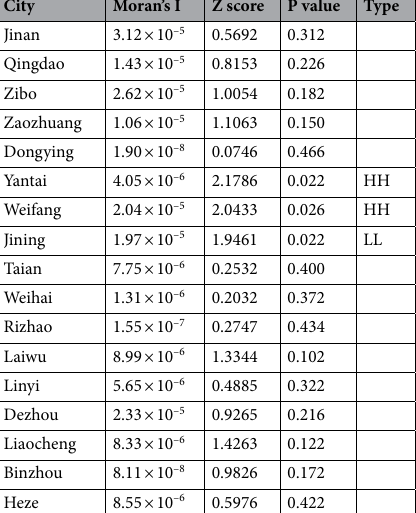
City Moran’s I Z score P value